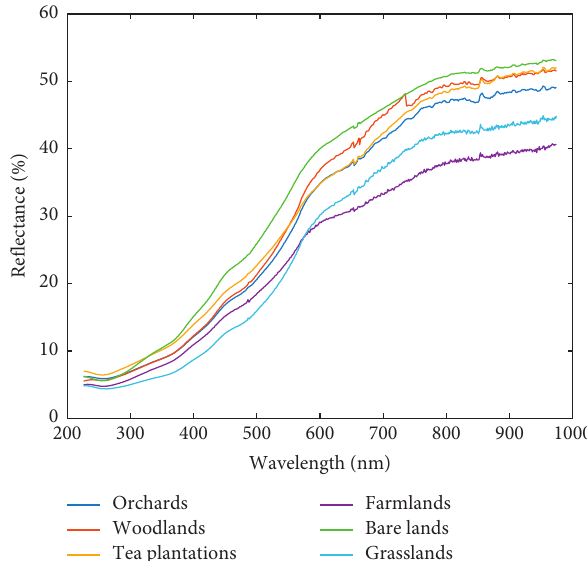
Figure 2: The average reflection spectrum of 6 types of